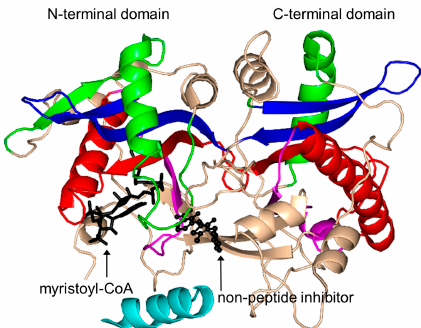
Figure 18. Cartoon representation of the structure of yeast N -myristoyltransferase in complex with myristoyl CoA and the non-peptide inhibitor ( Z )-3-benzyl-5-(2-hydroxy-3-nitrobenzylidene)-2- thioxothiazolidin-4-one (PDB ID: 2P6F [169]). The conserved and non-conserved motifs of the GNAT domain, cofactor and inhibitor are colored as in Figure 3.